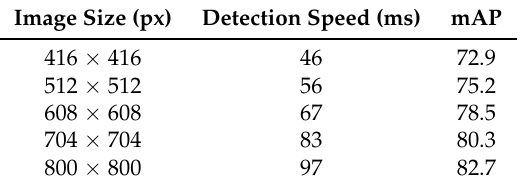
Table 1. The results of detection accuracy and detection speed for different image